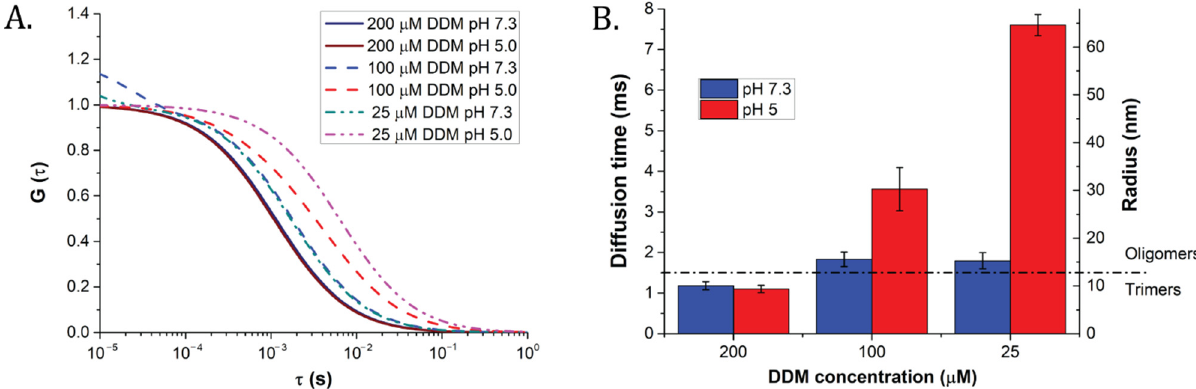
Figure 2. Averaged fittings of the autocorrelation functions and calculated diffusion times of LHCII trimers obtained by conventional (Levenberg–Marquardt) method. The full list of parameters obtained is presented in the Table 2. See Figures S2 and S3 for raw curves and weighted residuals of the fittings, respectively. ( A ) Averaged autocorrelation curves. A shift to longer diffusion times indicates an increased size of LHCII clusters. ( B ) Diffusion times and particle radii estimated from them (see the Section 4). The diffusion time threshold for a trimeric state of LHCII is marked with a dashed line. Results are the average of three independent measurements. Error bars: SD. Table 2. Properties of LHCII particles incubated at different pH and detergent concentrations on the basis of fluorescence correlation spectroscopy (FCS) measurements and fitted by Levenberg–Marquardt method (see Figure 2). Parameters were obtained assuming one single diffusional component. The calculated parameters include average diffusion time, hydro-dynamical radius of LHCII particle, total photon count rate per focal volume; N—number of LHCII particles per focal volume. Results from low-quality fittings are highlighted in gray (see the main text for more details). Error: SD. DDM